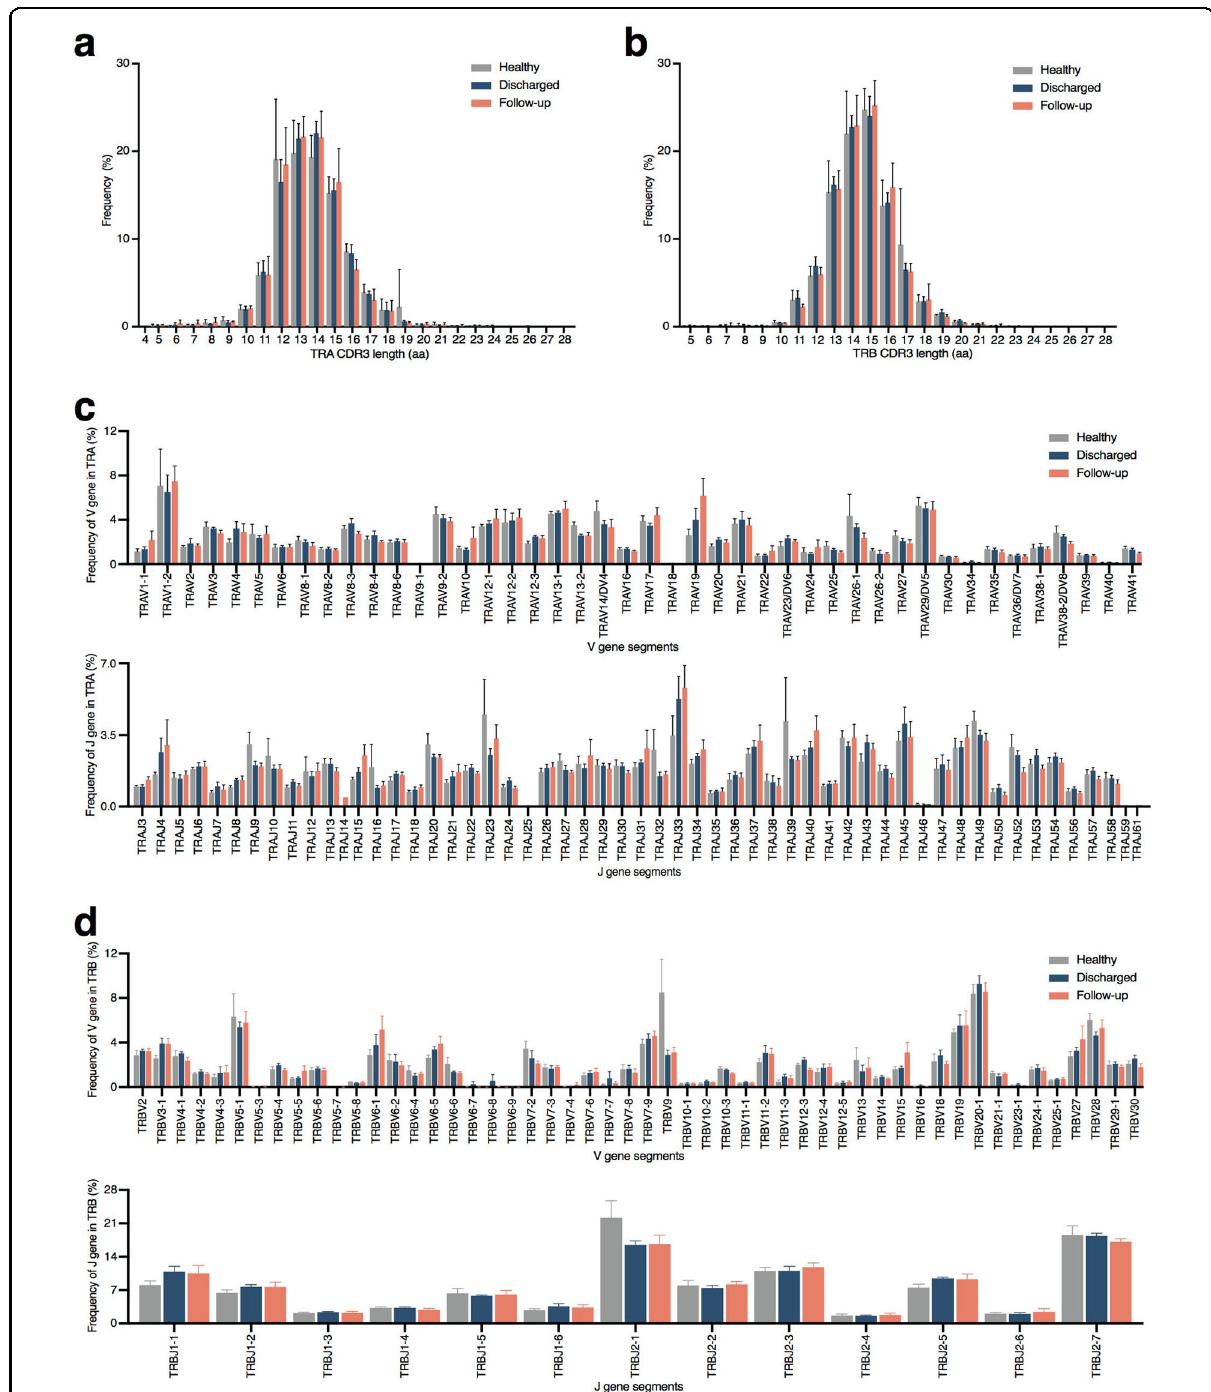
Fig. 2 Global CDR3 length and V/J distribution in samples. The amino acid length of CDR3 from TCR α chain ( a ) and TCR β chain ( b ) of HD group, Discharged group and Follow-up group ( n = 6 in Discharged and HD groups, n = 7 in Follow-up group). The usage rate of V and J regions from TCR α chain ( c ) and TCR β chain ( d ) of HD group, Discharged group and Follow-up group ( n = 6 in Discharged and HD groups, n = 7 in Follow-up group). HD, Healthy Donor